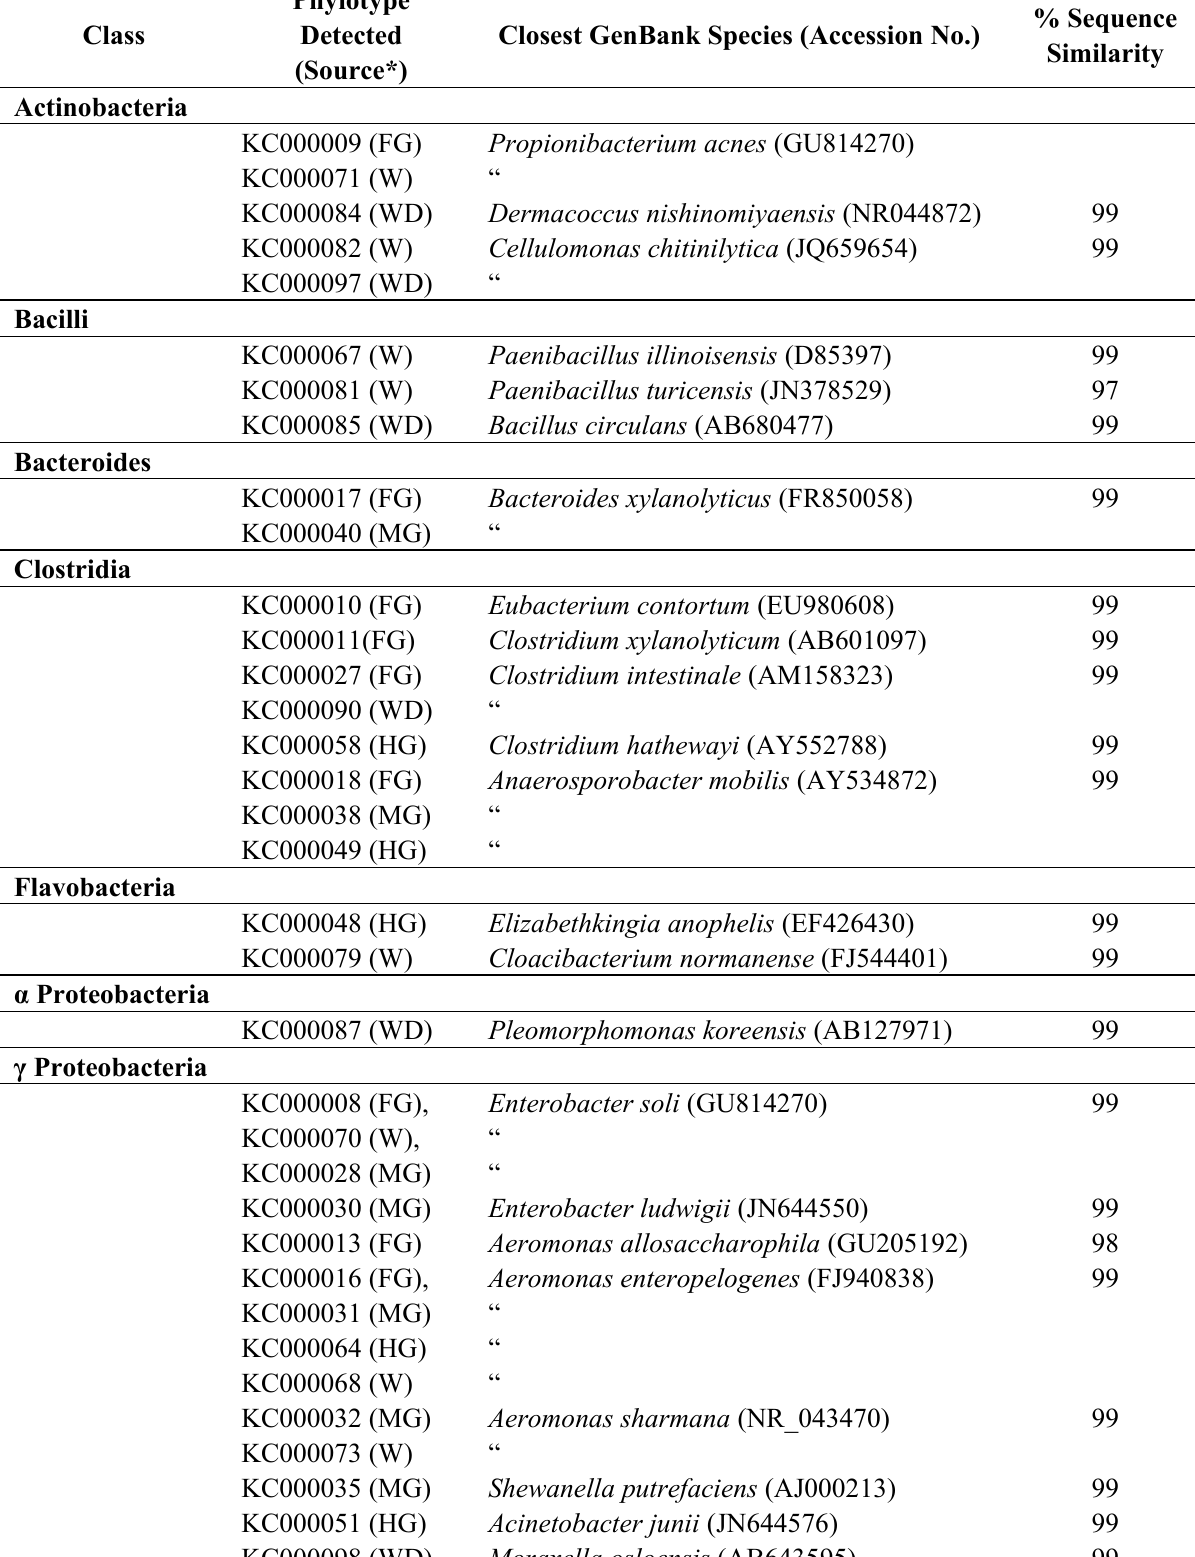
Table 1. Sequence similarity of the 16S rRNA gene from isolates obtained from cellulose enrichment cultures inoculated with different GI tract regions from P.